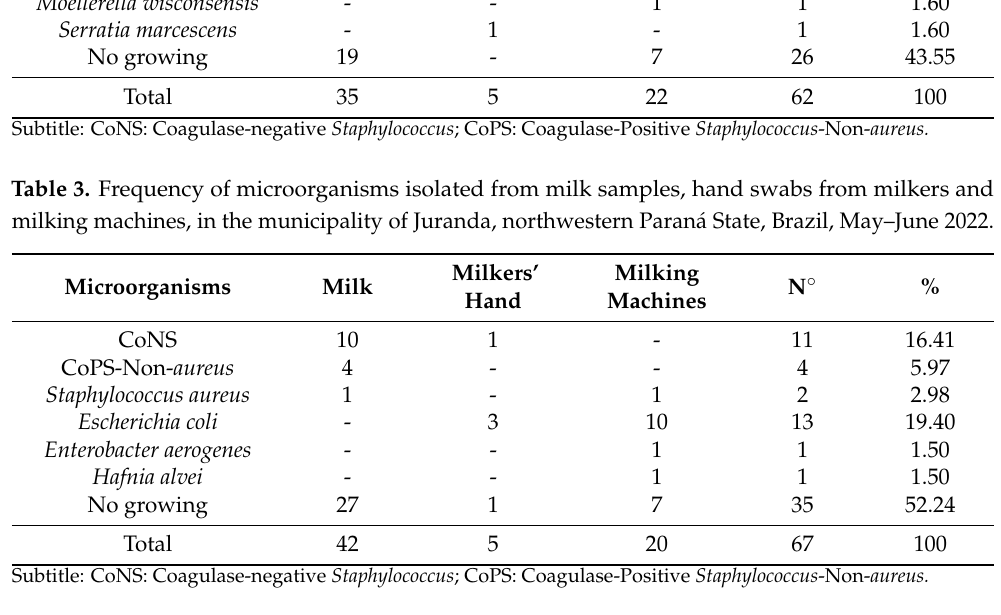
Citrobacter koseri